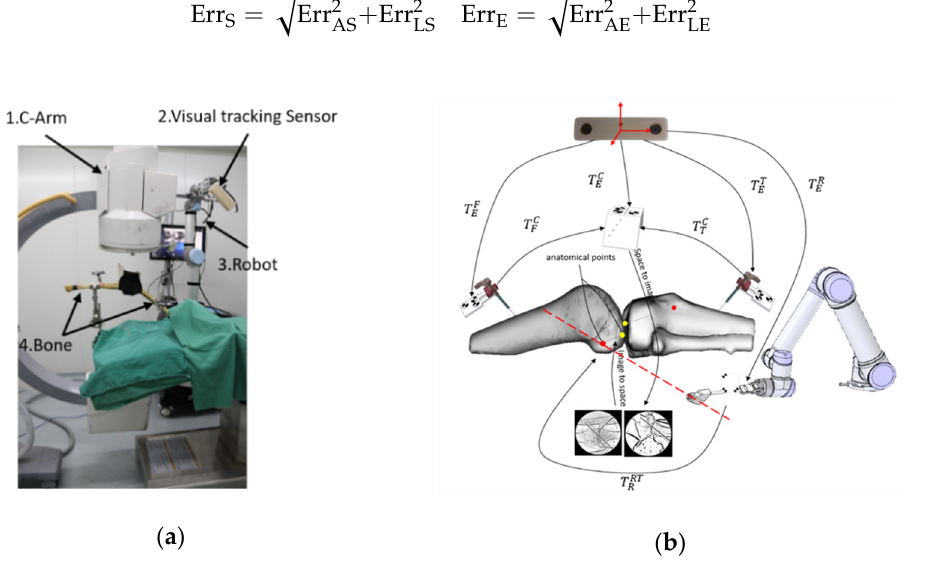
Figure 15. Experiment platform of navigation and positioning system: ( a ) Navigation System, which included C-Arm, visual tracking sensor, robot and bones; ( b ) Spatial transformation, T F represented transformation matrix of femur space and world coordinate system, T C represented transformation matrix of calibrator and femur space, T C represented transformation matrix of calibrator and world coordinate system, T C represented transformation matrix of calibrator and tibia space, T T represented transformation matrix of tibia space and world coordinate system, T R represented transformation matrix of tool coordinate system of robot and world coordinate system, T RT represented transformation matrix of reconstruction target and tool coordinate system of robot. Yellow points were end points of reconstruction tunnels, and red points were start points of reconstruction tunnels.